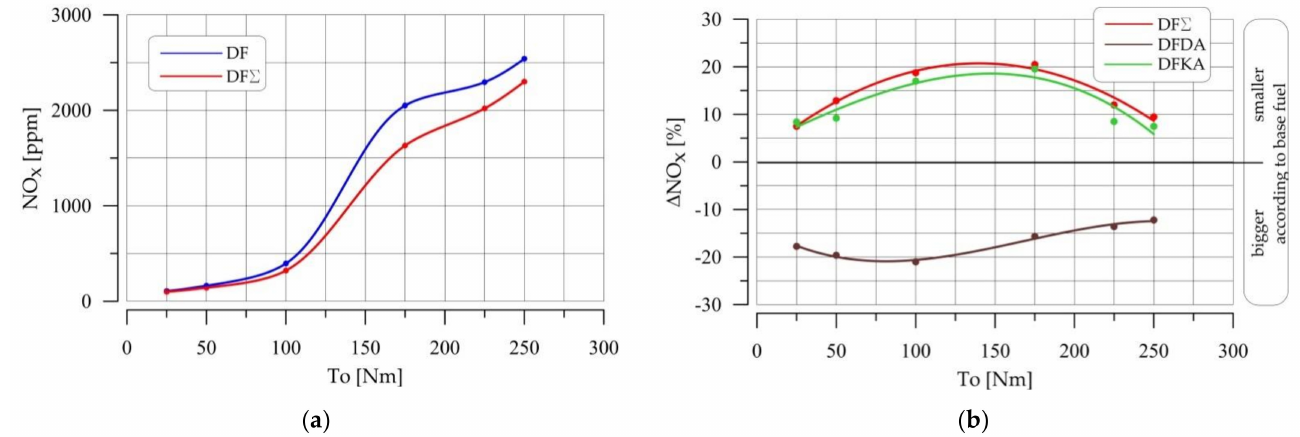
Figure 12. ( a ) Concentration of NO x in the exhaust fumes vs. engine torque; ( b ) Percentage difference in the concentration of NO x in the exhaust fumes vs. engine torque in relation to the base